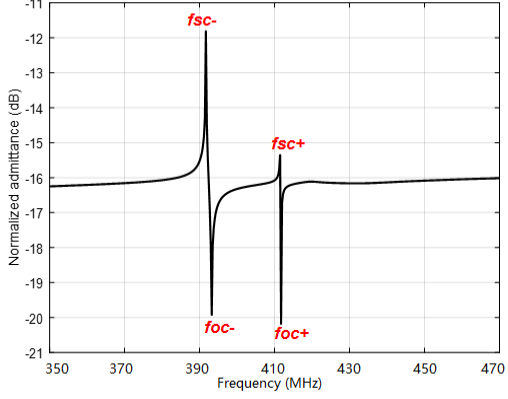
Figure 10. Normalized input admittance. Table 2. COM parameters of SAW device with structure of Pt/LGS.